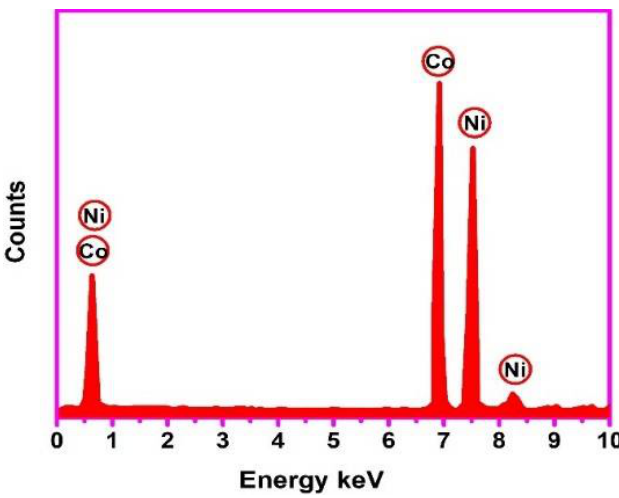
Figure 4. EDX spectra analysis of BM50-100 sample.